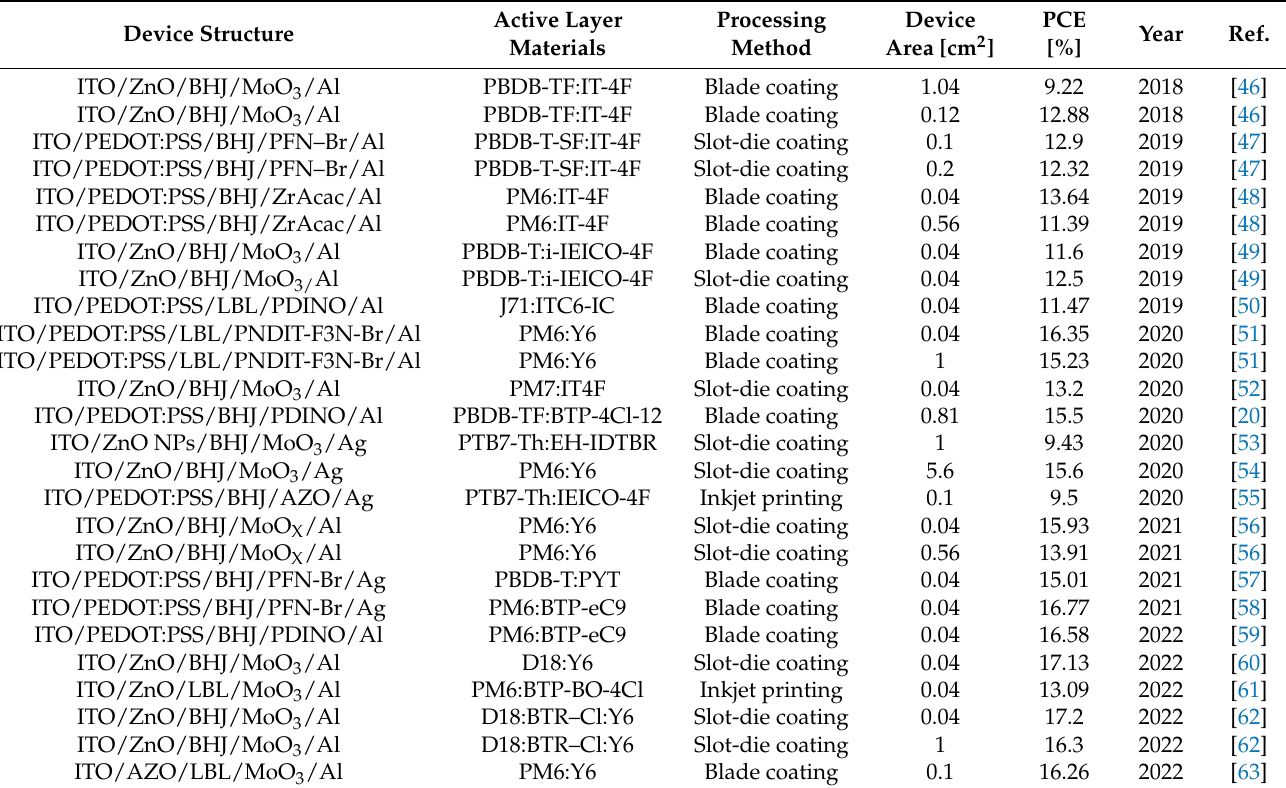
Table 1. The performance of NFA-based OSCs by printing